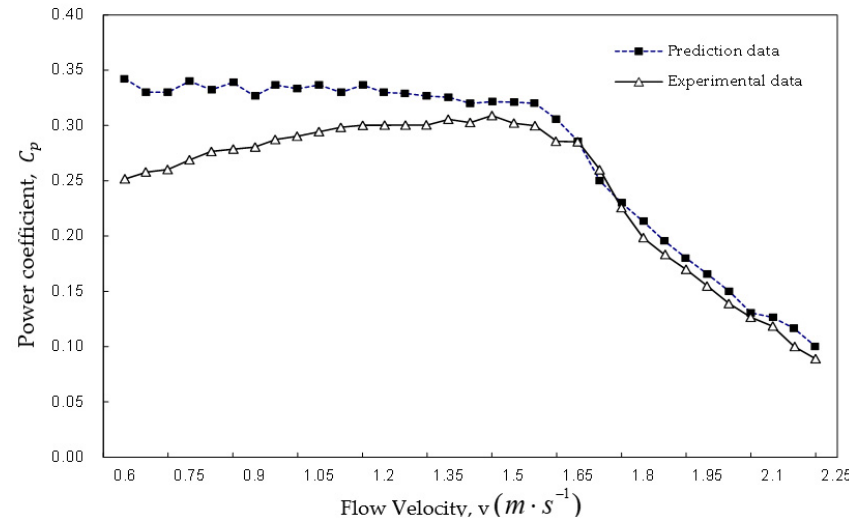
Figure 11. Comparison of prediction and experimental data.